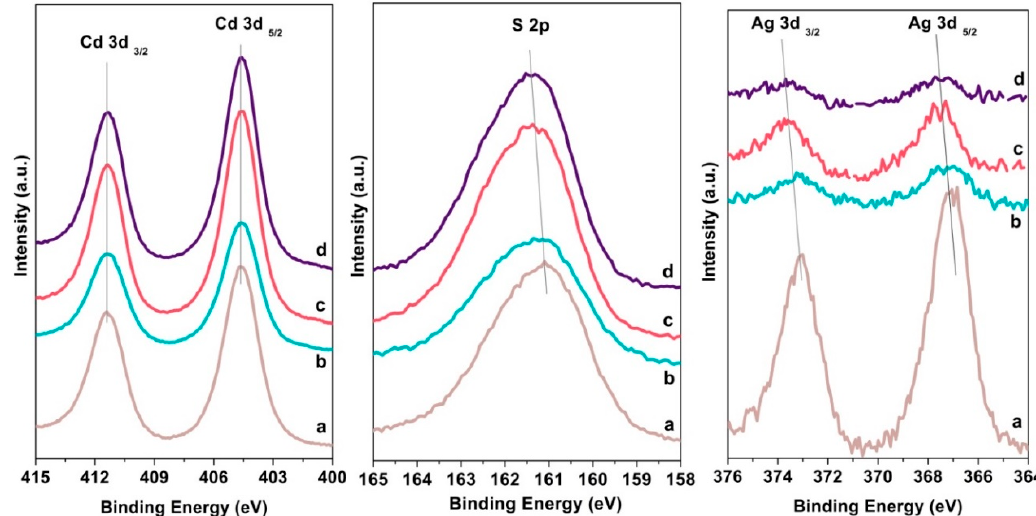
Figure 3. XPS core-level spectra from Cd 3d, S 2p and Ag 3d core levels of AgCdS-T: ( a ) T = 90 ◦ C; ( b ) T = 120 ◦ C; ( c ) T = 150 ◦ C; and ( d ) T = 190 ◦ C. Table 3. XPS binding energies (eV) of core levels and surface composition (atomic percentages) of AgCdS-T photocatalysts. Cd 3d 5/2 Ag 3d